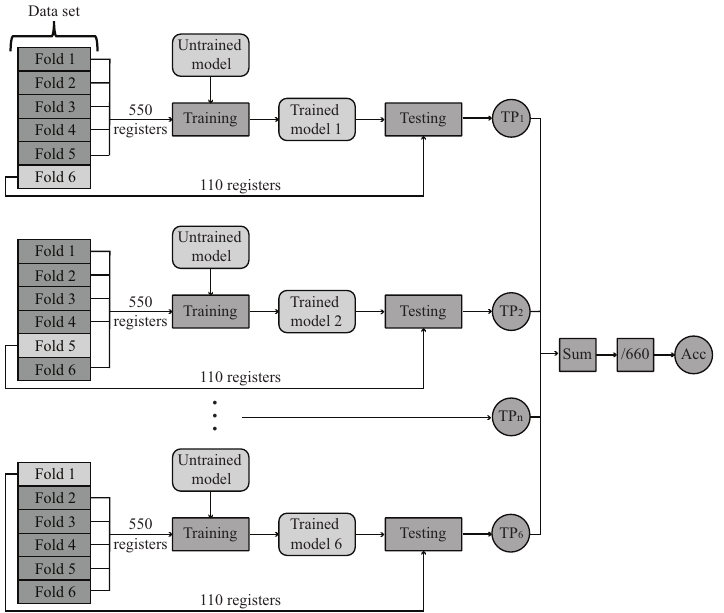
Figure 11. Cross validation process for the machine learning model training and